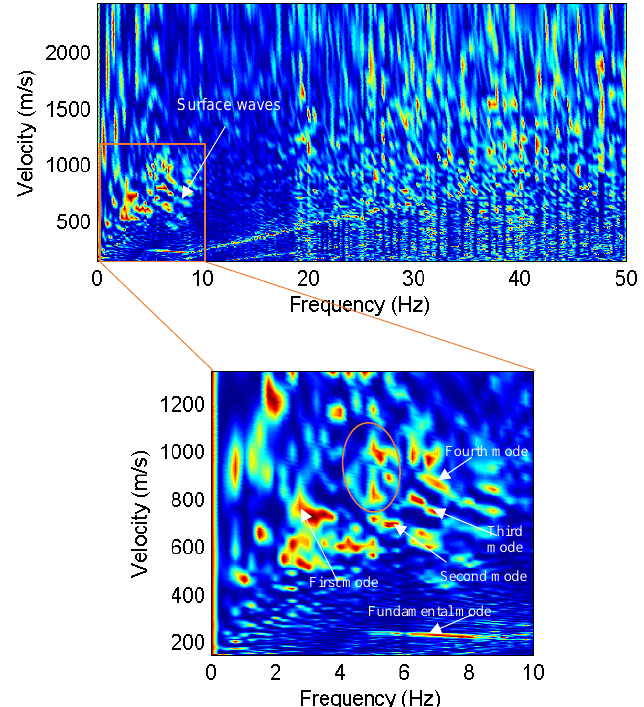
Figure 10. An image of dispersive energy of the field data in the f-v domain.